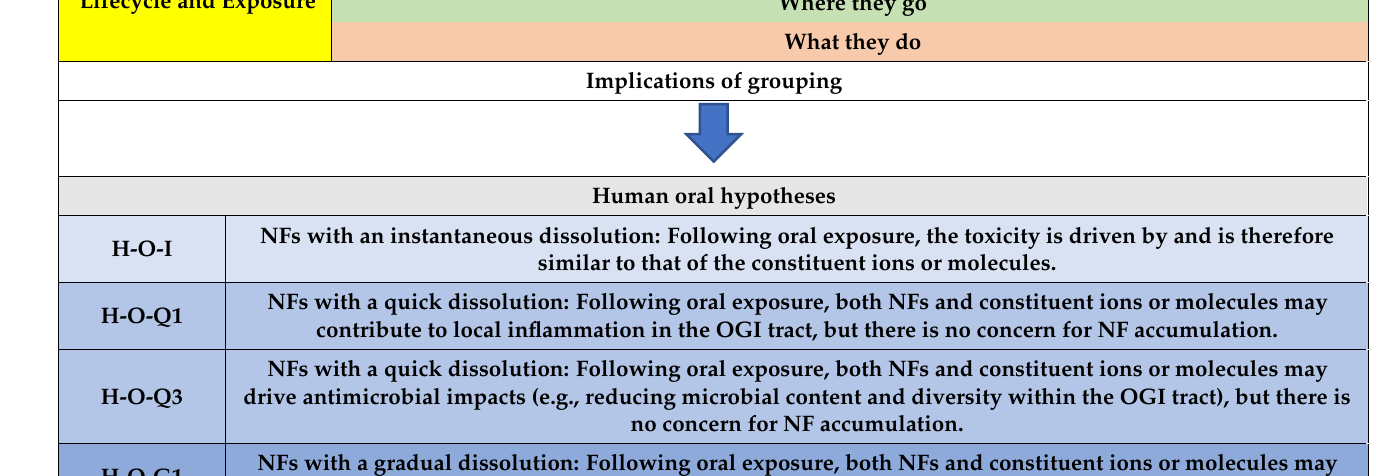
Table 1. (Above): GRACIOUS template for generating grouping-based hypotheses [20,25]. (Below) Human oral hypotheses (H-O-) developed for oral ingested NFs. Purpose of Grouping and Context What they are Where they goLifecycle and Exposure What they do